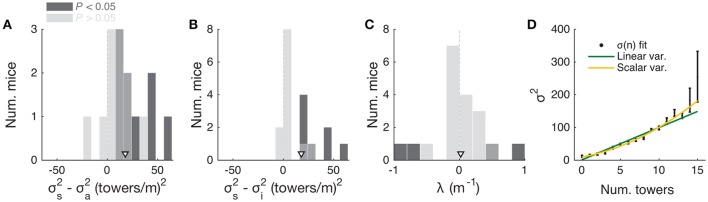
Behavioral performance seems to be limited by cue-dependent noise. (A) Distribution across mice (n = 20) of the difference between best-fit sensory and diffusion noise parameters (σ2s and σ2a, respectively) from the Brunton et al. model, color coded according to whether they are significantly different from zero according to 95% confidence intervals determined from cross-validation runs. Arrowhead, population mean. (B) Distribution across mice of the difference between best-fit sensory and initial noise parameters (σ2s and σ2i, respectively) from the Brunton et al. model. Conventions as in (A). (C) Distribution of the memory leak (λ) parameter from the Brunton et al. model. Conventions as in (A). (D) Best-fit parameters for the SDT model (aggregate mouse data). Black data points: parameters from the full model where σ2 is determined separately for each tower count. Yellow line: prediction from the two-parameter scalar variability model. Green line: prediction from the two-parameter linear variance model. Scalar variability yielded significantly better predictions (P < 0.003). Error bars: standard deviation from bootstrapping iterations (n = 200).